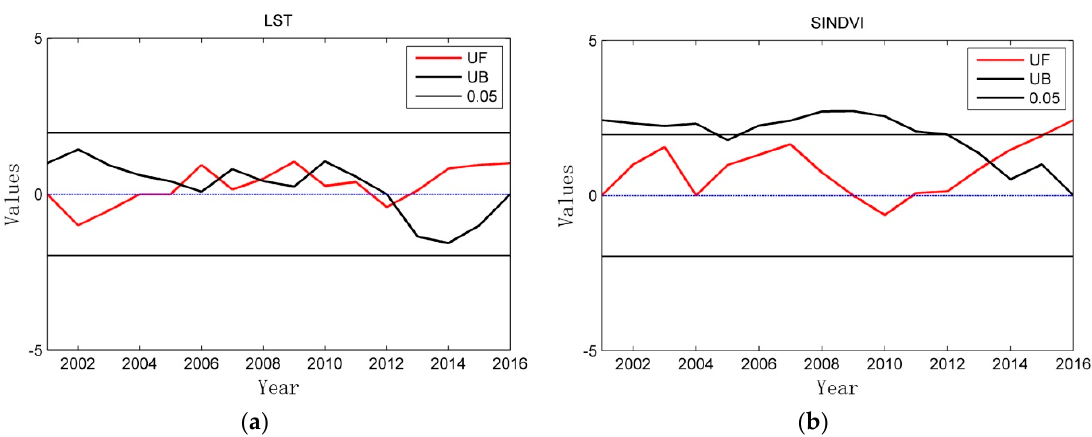
Figure 5. The significant trend of annual ( a ) LST, and ( b ) SINDVI at the southeastern region of Bangladesh from 2001 to 2016 (Note: U B = − U F; Significance tested at α = 0.05). The figure for the significance test of the trend of LST and SINDVI has been drawn by a non-parametric M–K test. The Mann–Kendall (M–K) changing parameters (UB and UF) curve line shows a statistically